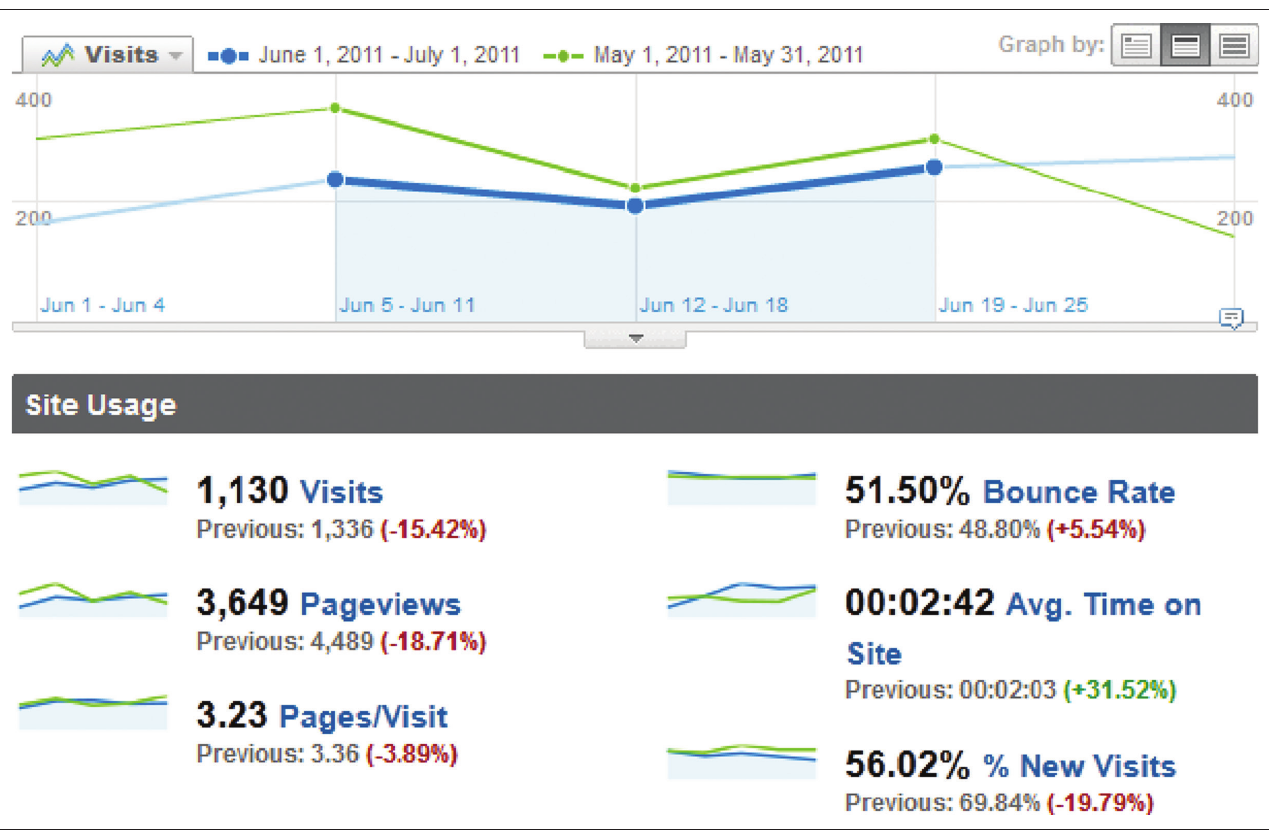
FIGURE 1: Effect of header tag improvement on website visitations.